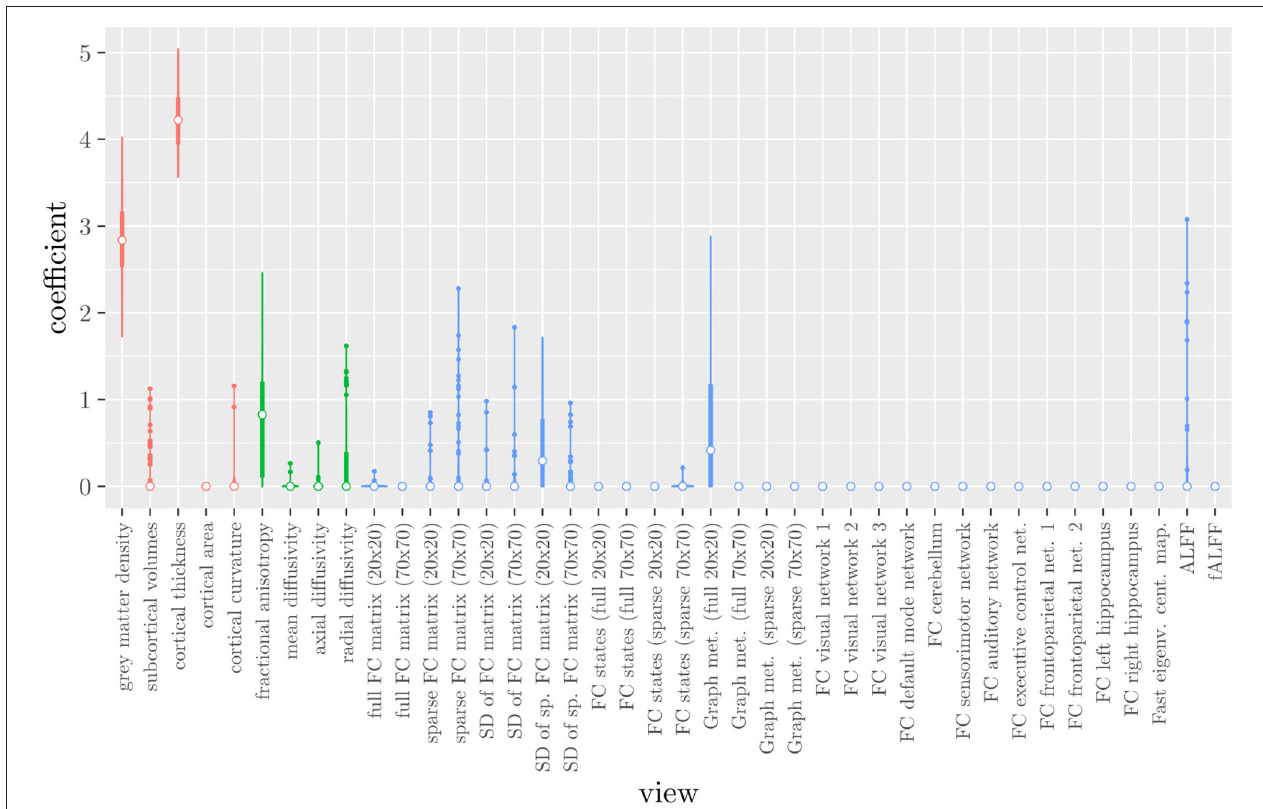
FIGURE 3 | Boxplots of the regression coefficients of StaPLR applied with only 2 levels, using the MRI measures as views, colored by scan type (red = structural MRI, green = diffusion MRI, blue = resting state fMRI).